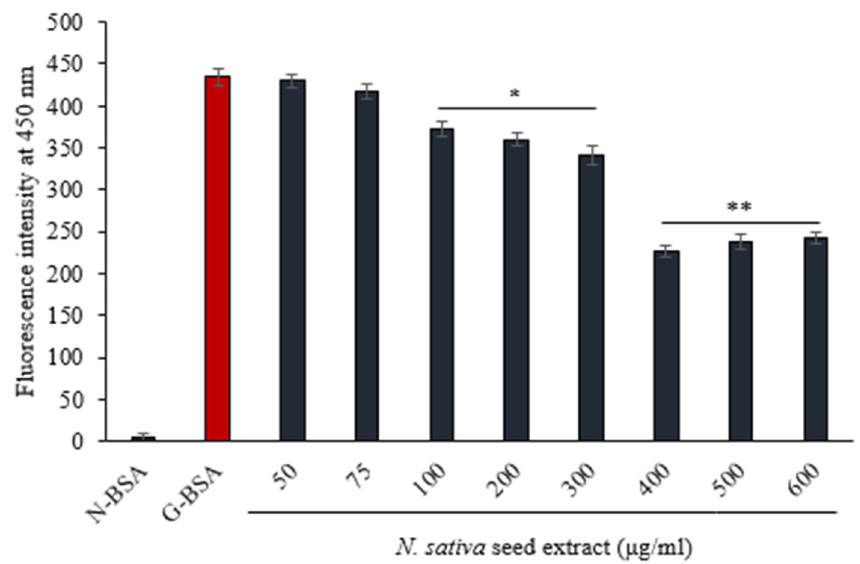
Figure 7. Effect of N. sativa seed extract on AGEs formation. N-BSA: Native BSA incubated alone for 15 days. G-BSA: BSA incubated with glucose for 15 days and considered as negative control. The results are presented as means ± SEM ( n = 3, (* p ≤ 0.01, ** p <0.05).